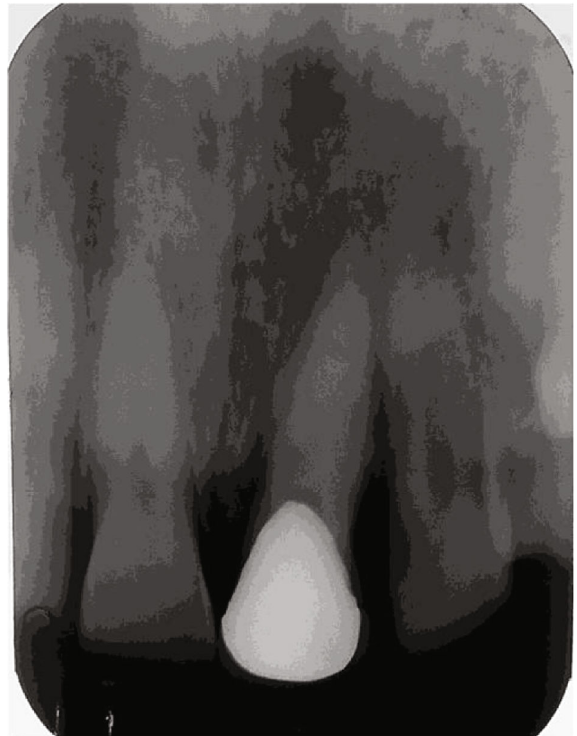
Figure 8: Two years of follow-up.